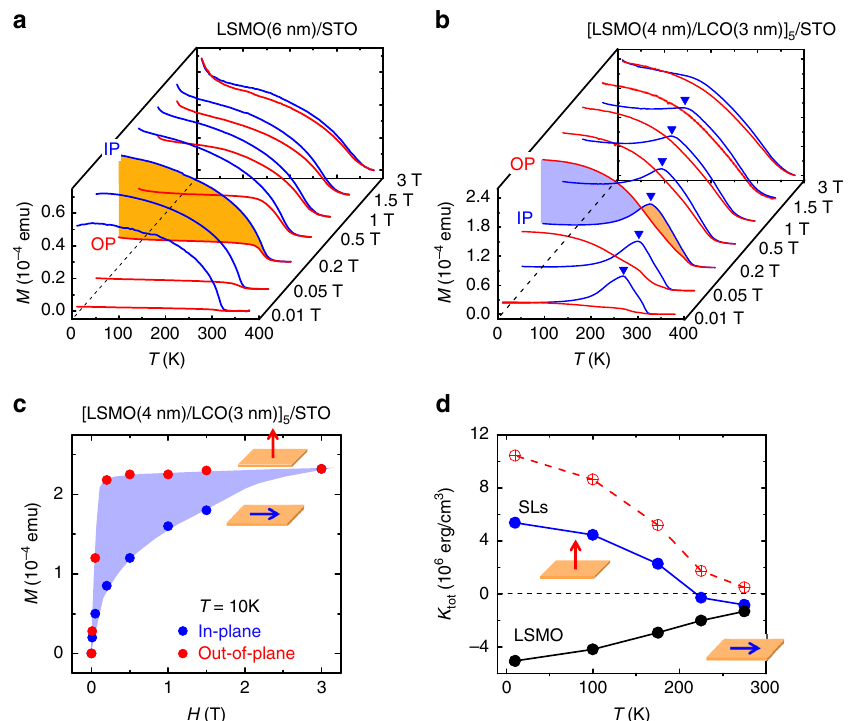
Fig. 3 Magnetic behaviors of the LSMO fi lm and the LSMO/LCO SLs. a , b Thermomagnetic curves of the LSMO fi lm (6 nm) and the LSMO(4nm)/LCO(3 nm) SLs, respectively. The data were acquired in fi eld-cooling mode with in-plane (IP) or out-of-plane (OP) applied fi elds. Purple and orange areas highlight the difference of the magnetic moments along two measuring directions. Two M – T curves recorded along the in-plane and the out-of-plane directions, respectively, sometimes cross one another, as the spin re-orientation has changed relative variations of the magnetic moment with temperature along these two directions. Blue triangles mark the temperature for spin reorientation. c Magnetic moment as a function of applied fi elds, extracted from the data in b at T = 10 K. Shaded area corresponds to the energy required to orientate magnetic moment towards fi lm plane. Here, the data at 10 K were presented simply because that our measuring system is most easily thermally stabilized at this temperature. At low temperatures well below the Curie temperature, the magnetic properties of the multilayers are nearly temperature independent. d Anisotropy constant of the LSMO(4 nm)/LCO(3 nm) SLs (blue curve) and the plain LSMO fi lm (black curve). The expected anisotropy constant of the SLs is presented by a dashed shown by the dashed line in Fig. 3e. It reaches a value as high as 1.04 × 10 7 erg cm − 3 at 10 K.